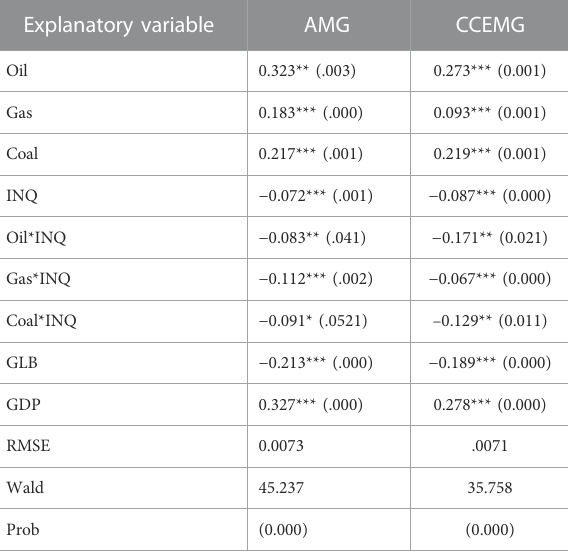
TABLE 3 Cointegration results.